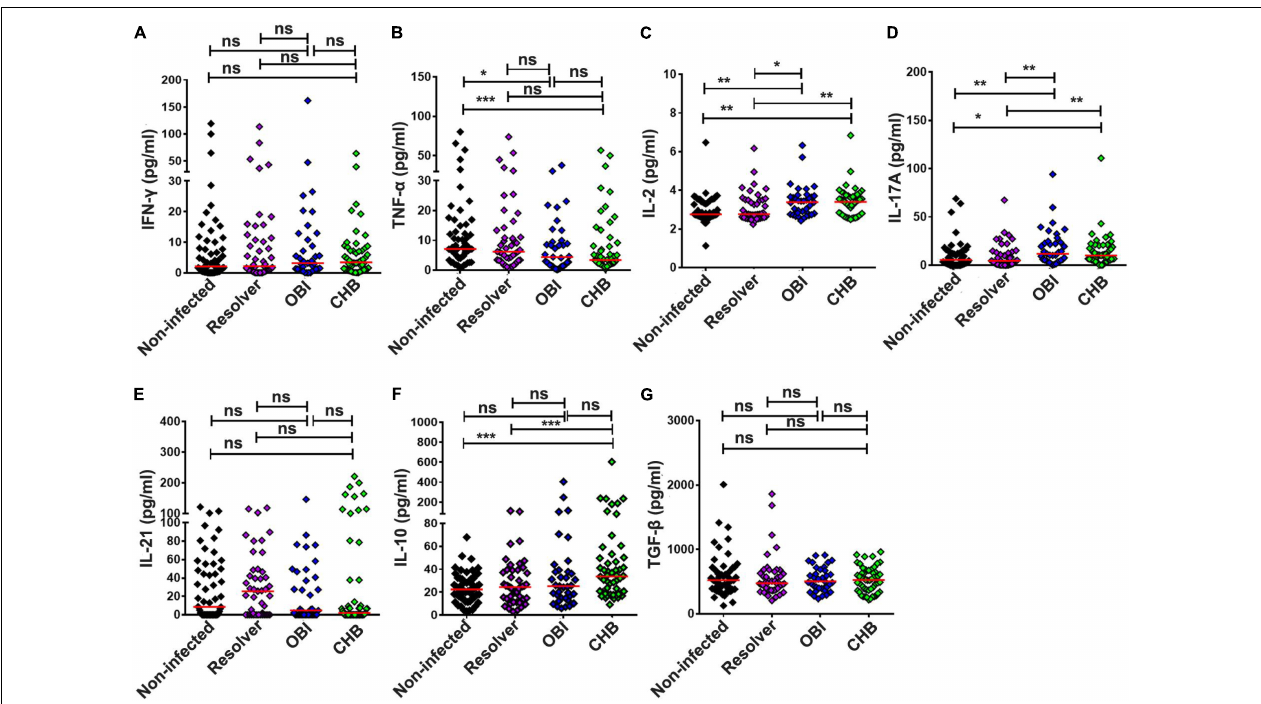
FIGURE 6 | Extracellular cytokine concentrations in the culture supernatants of PBMCs stimulated by HBV core peptides. The concentration of IFN- γ (A) , TNF- α (B) , IL-2 (C) , IL-17A (D) , IL-21 (E) , IL-10 (F) , and TGF- β (G) in the supernatants of PBMCs was individually quantified by CBA after 72 h of stimulation. The result is expressed as the mean of triplicates. A median cytokine concentration in each group is indicated and the differences between groups are compared with the Mann–Whitney test. Statistically significant differences are shown with asterisks (* P < 0.05, ** P < 0.01, and *** P < 0.001); ns, no significant